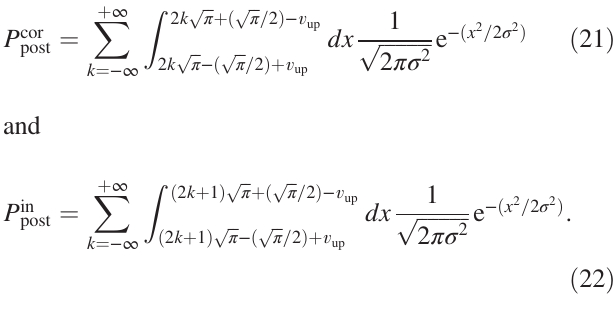
¼ 0 (red ffiffiffi p up ¼ π = 6 (blue up